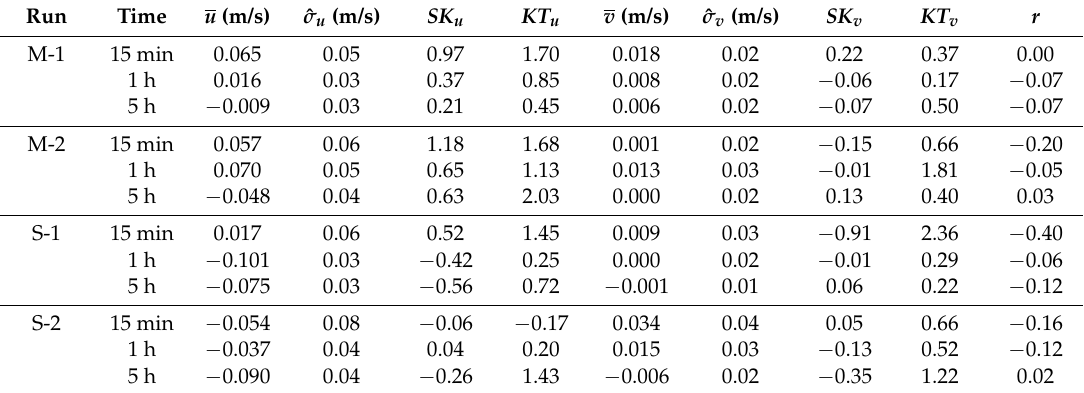
Table 2. Summary of the temporal variations in the first four moments and the correlation coefficients of the longitudinal and vertical velocities at the lowest point of the scour